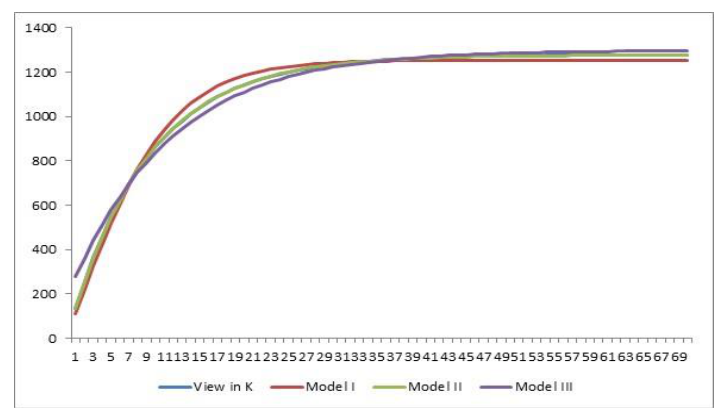
Figure 6. Goodness of fit curve of Dataset